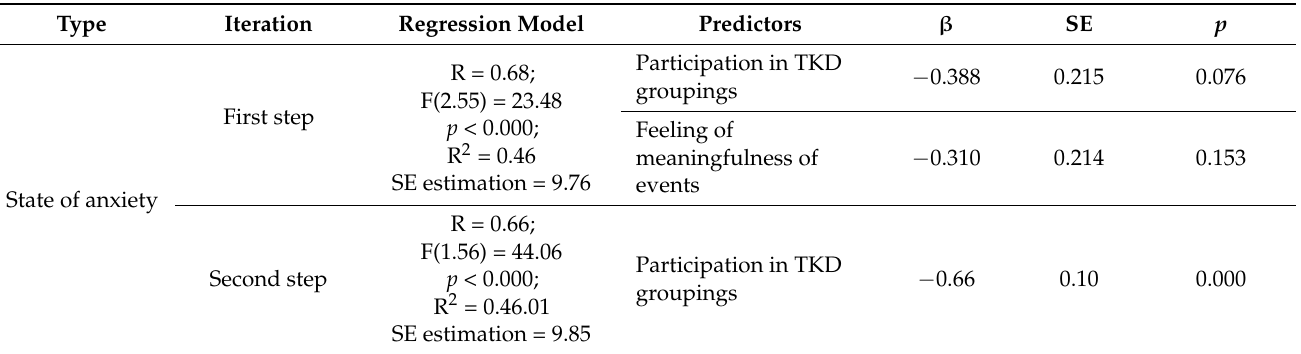
Table 3. Multiple regression models (stepwise regression) of state of anxiety level in the context of selected predictor